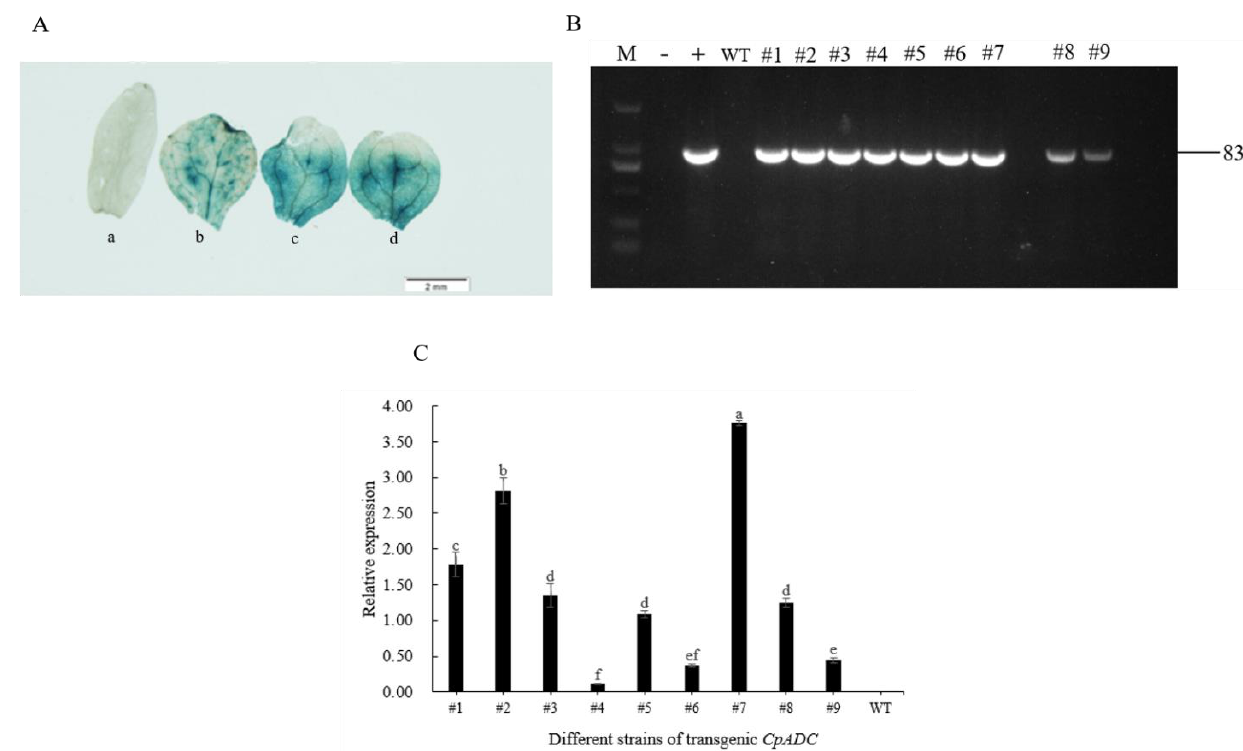
Figure 2. Identification and expression analysis of transgenic strains ( A ) The histochemical staining of GUS from the transgenic plants. Note: a: WT; b,c,d: transgenic Arabidopsis plant. Scale bars = 2 mm ( B ) DNA detection of T1 generation of transgenic Arabidopsis plant. Note: M: DL 2000 DNA Marker; -: H 2 O, +: recombinant vector plasmid, #1–#9: transgenic Arabidopsis plant lines. ( C ) Expression analysis of CpADC in nice transgenic lines by qRT-PCR. #1 – #9: transgenic Arabidopsis plant lines; Note: Different lowercase letters are used to indicate means that differ significantly ( p ≤ 0.05), WT: Colombia wild type Arabidopsis.